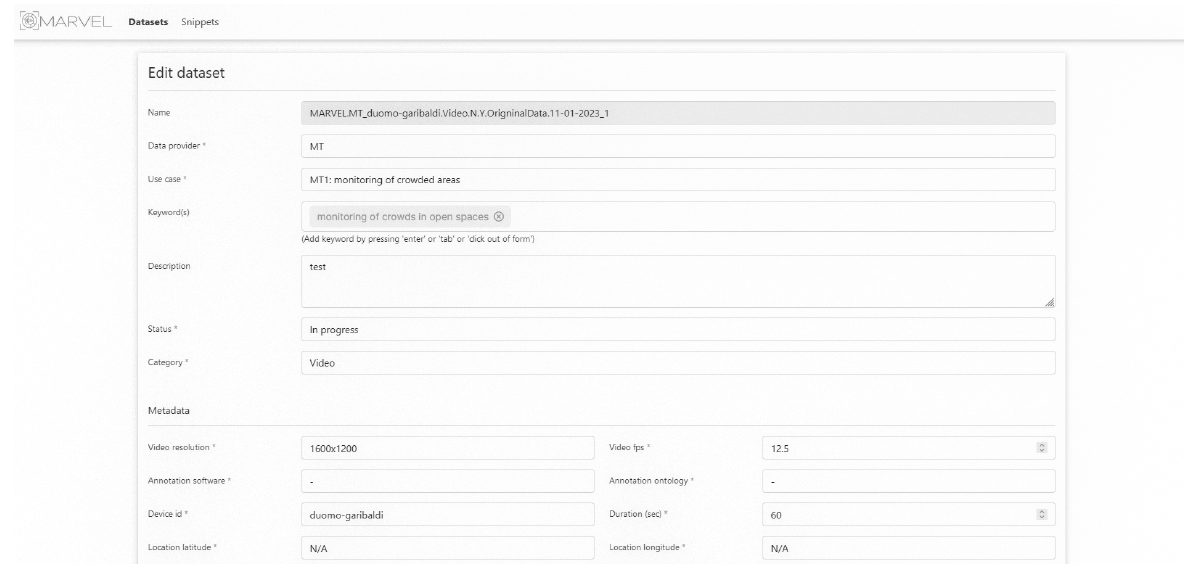
Figure 8. GUI: main Dashboard (edit